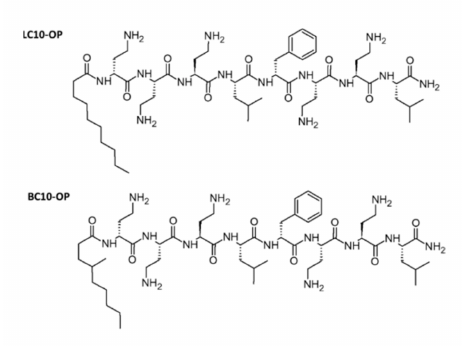
Scheme 1. Chemical structure of